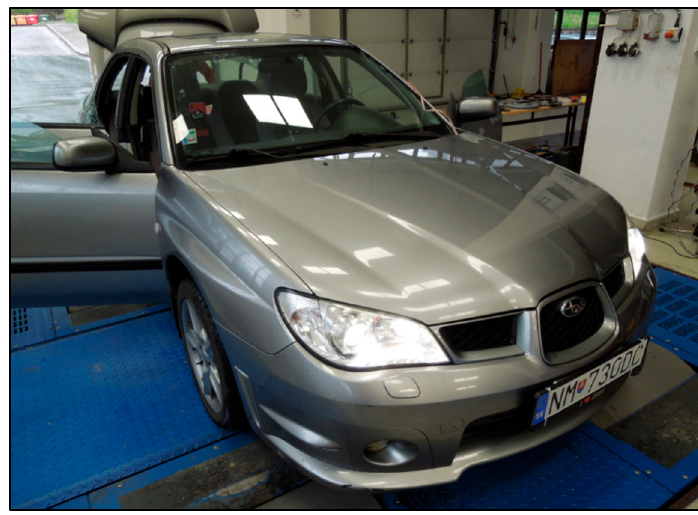
Figure 11. Measured vehicle Subaru Impreza [author]. Table 3. Technical parameters of the measured vehicle [certificate of registration].